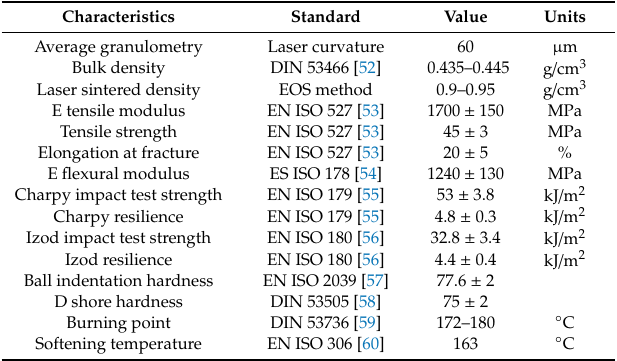
Table 4. Characteristics of the PA 2200 polyamide according to the supplier’s technical